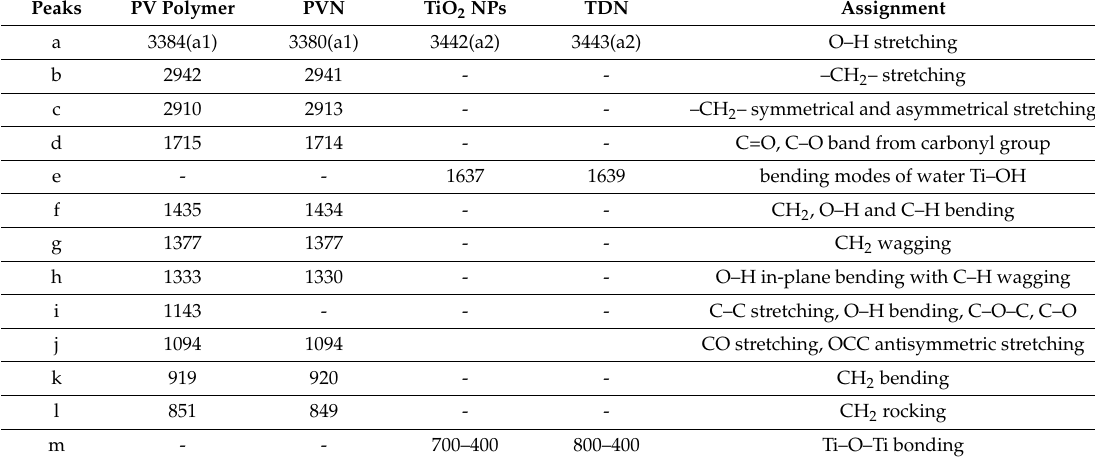
Figure 7. FTIR spectra of PV polymer (black), uncoated PVN (grey), ALD-coated PVN_200 (blue), commercial TiO 2 NPs (pink) and TDN (green) and letter a-l correspond to specific peaks from Table 2. Table 1 . Characteristic wavenumbers expressed in (cm − 1 ) associated to assignments of FTIR absorption bands of PV polymer, PVN and TiO 2 nanostructures.